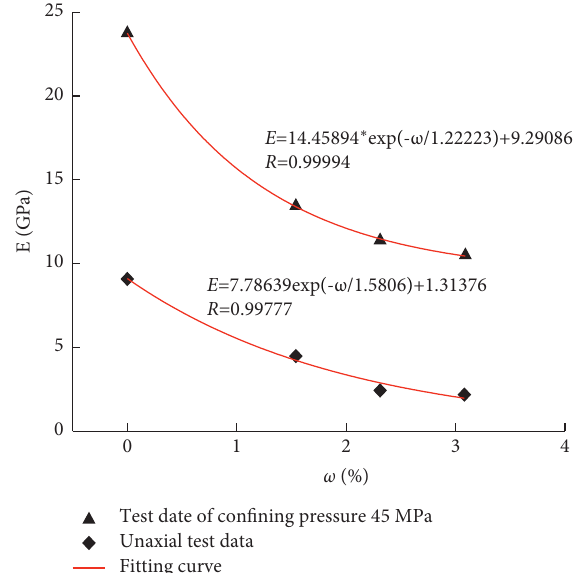
Figure 8: Relationship between elastic modulus and water